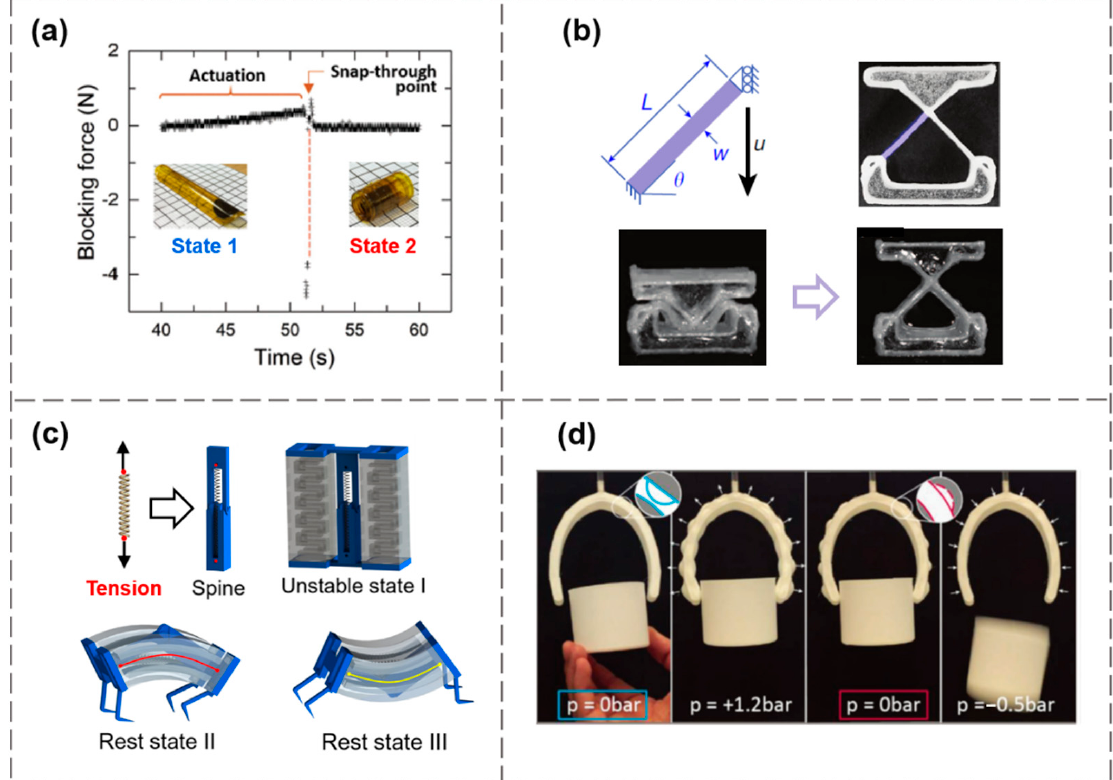
Figure 9. Soft actuators inspired by snap-through bistability. ( a ) A DEA mimicking insect capture. Reproduced from Ref. [33]; ( b ) The rapid snap-through actuation of a hydrogel composite with the initial geometry near the bifurcation point. Reproduced from Ref. [54]; ( c ) A spine-inspired bistable soft pneumatic actuator. Reproduced from Ref. [62]; ( d ) A pneumatic gripper with a dome-pat-terned outer skin. The reversible inversion of domes causes a grabbing force on an object, even without the external pressurization. Reproduced from Ref. [63].